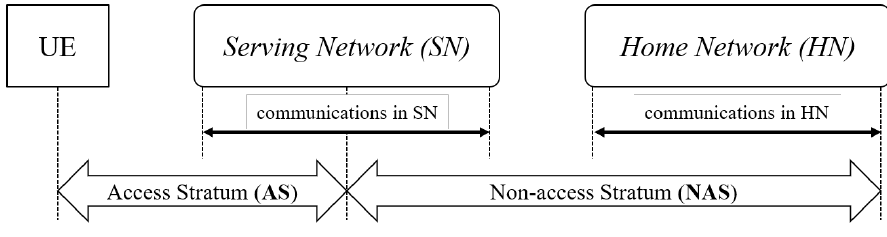
Figure 4. Types of Communications for Authentication in 5G. Table 3. Cost Terms on Communication Types of 5G